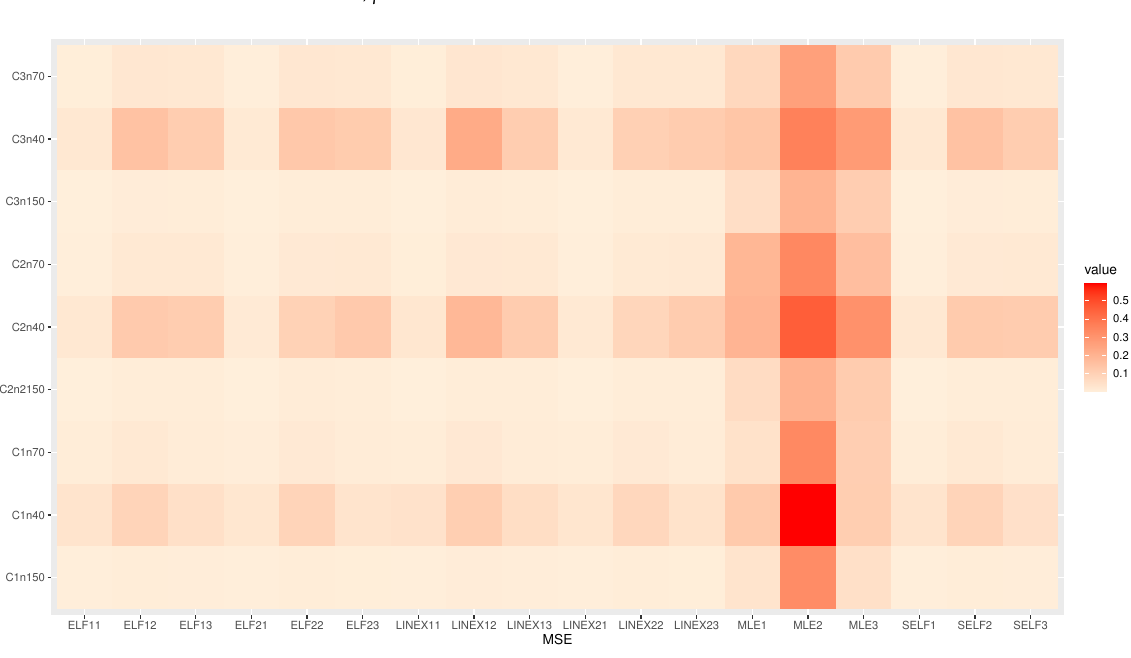
Figure 6. Heatmaps of MSE values for parameters of the KMWE distribution with different sample cases: α = 0.5, β = 0.4.